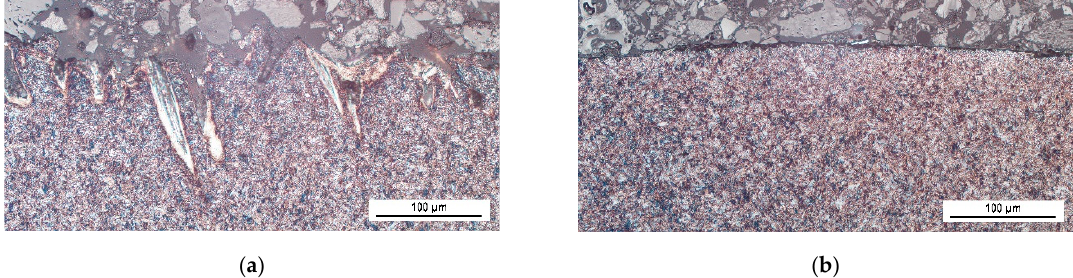
Figure 6. Metallographic images of phosphated wires surface—cross-sections: ( a ) position 2, ( b ) position 4.